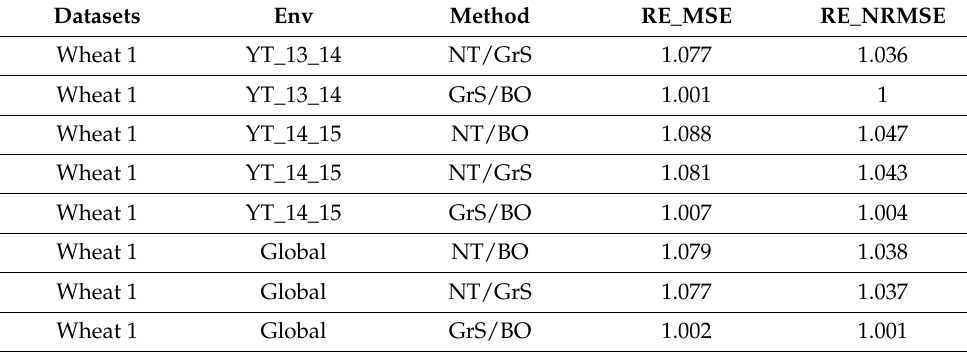
Table A2. Prediction performance for each environment and across environments (Global) of dataset 1 in terms of their relative efficiencies (RE) under two metrics (MSE and NRMSE). In the column “method” we represent the two tuning strategies that were used to compute RE_MSE and RE_NRMSE.